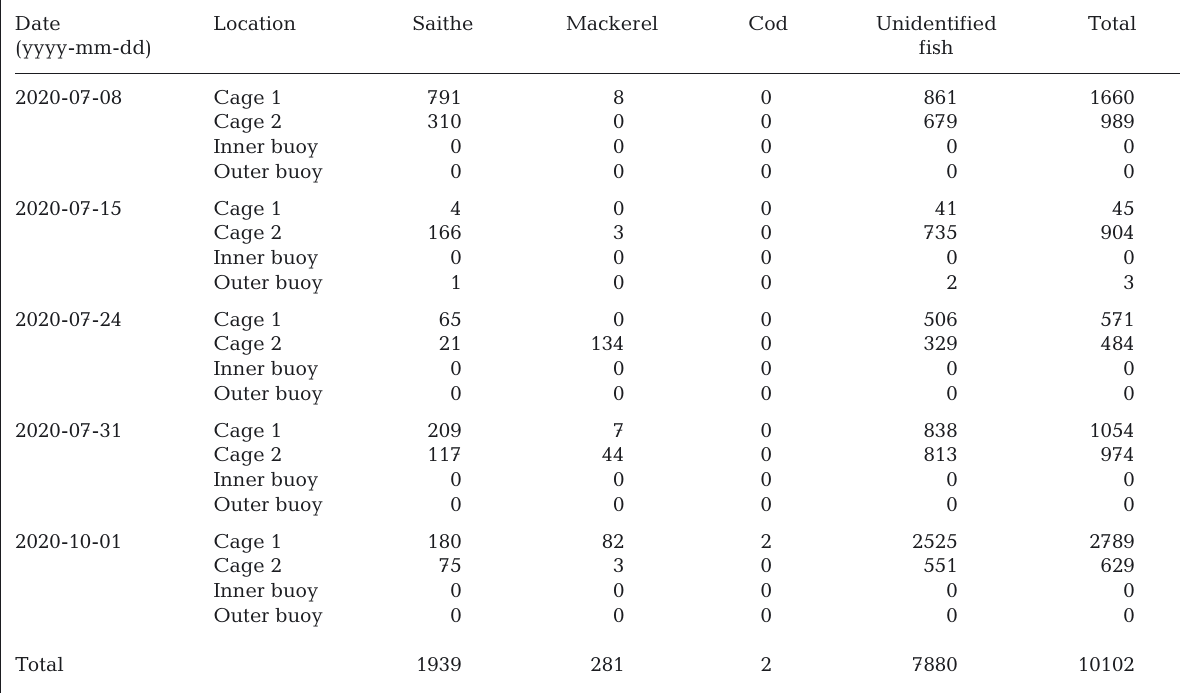
Table 2. Manual fish count results. Each value is the sum of detected objects under each category. Values for each cage are the sum of detected objects in a total of 864 images per sampling date. Values for each buoy are the sum of detected objects in a total of 144 images per sampling